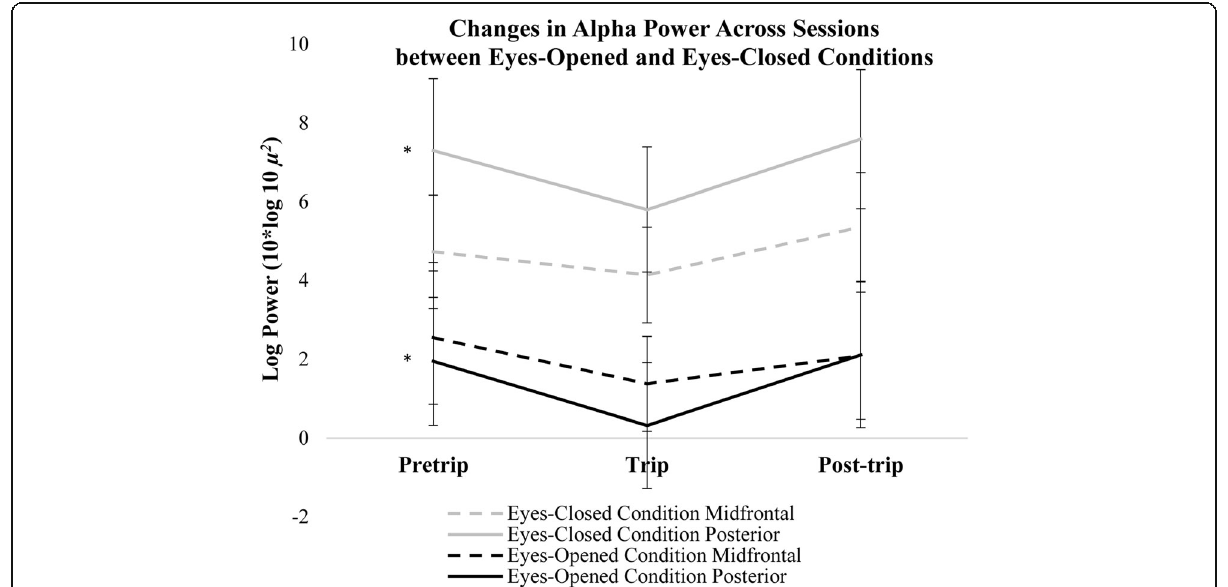
Fig. 6 Changes in log transformed alpha power (8 – 12 Hz) across sessions during the eyes-opened and closed conditions. Error bars indicate 95% confidence intervals around the mean. * p < 0.01